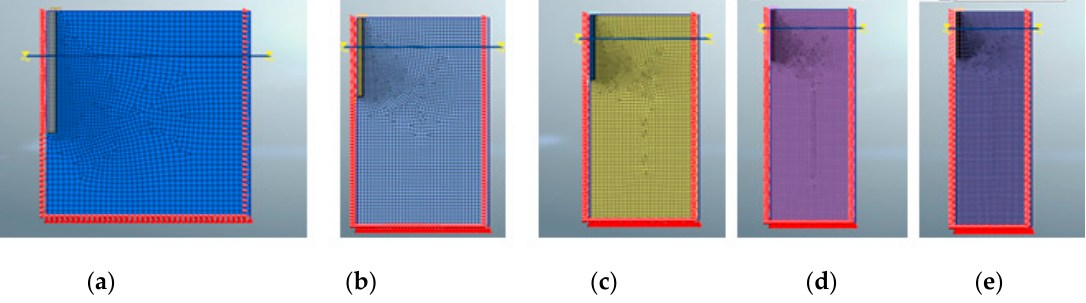
Figure 7. Five finite element models of with different depths. ( a ) 15 m × 16 m, ( b ) 15 m × 25 m, ( c ) 15 m × 30 m, ( d ) 15 m × 40 m, ( e ) 15 m × 45 m.